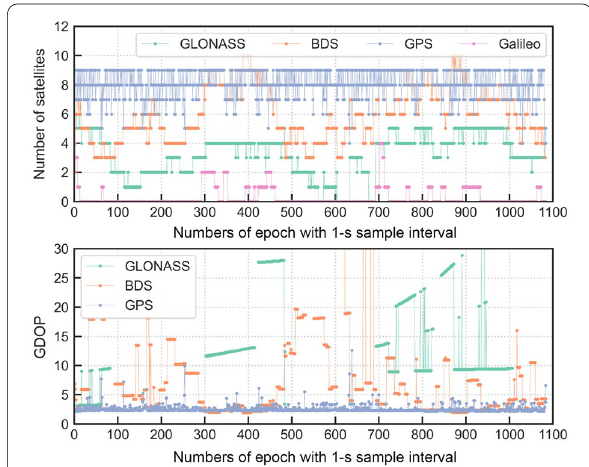
Fig. 18 Numbers of visible satellites and GDOP values of different systems in the kinematic